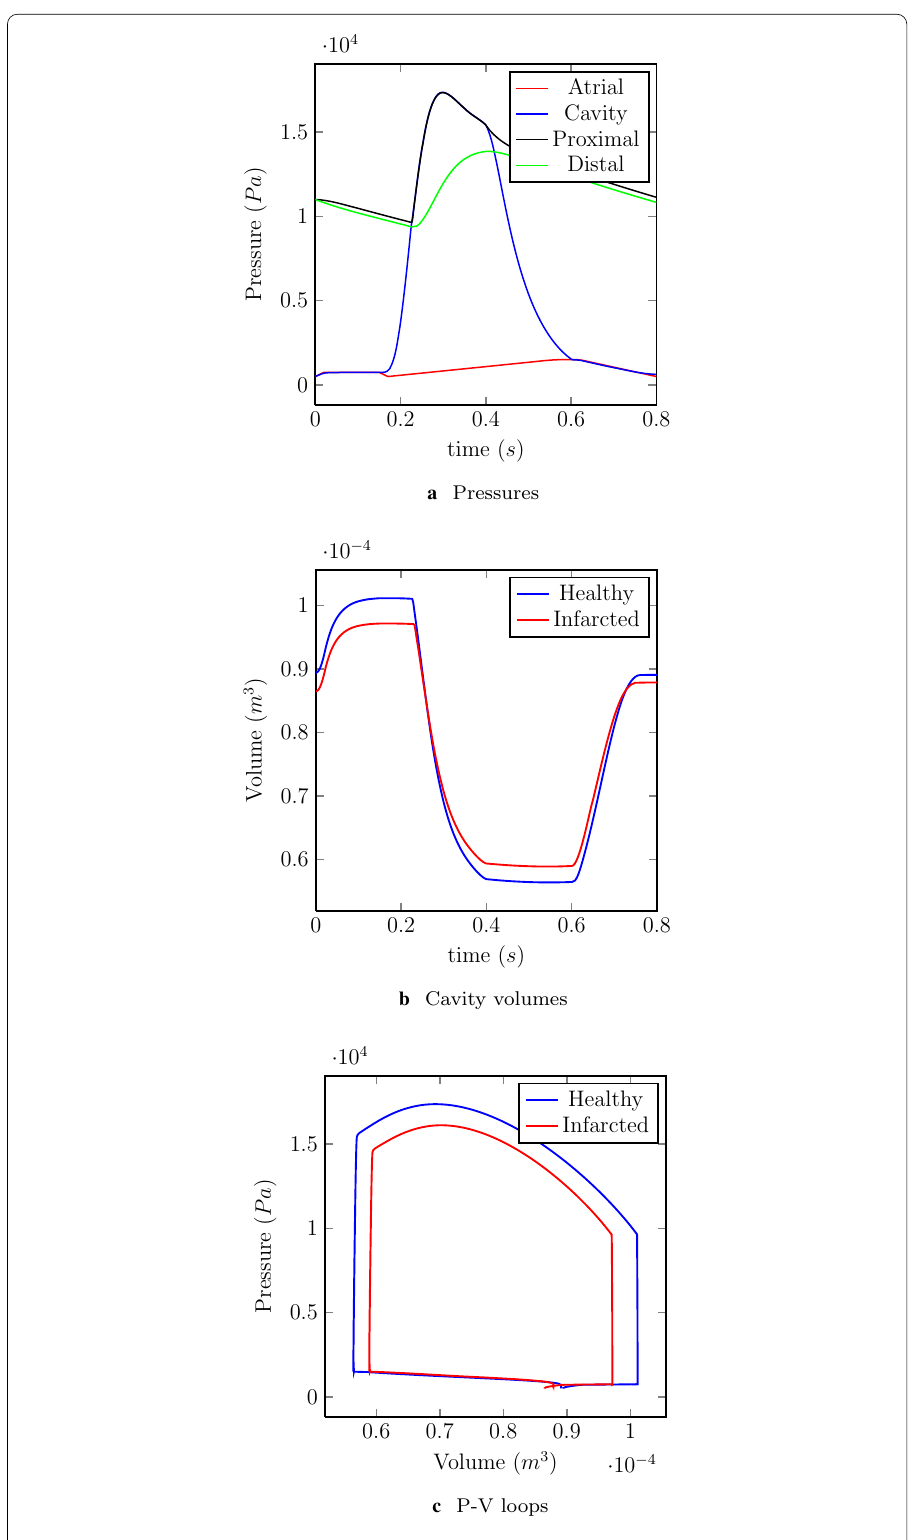
Fig. 7 Some indicators obtained from direct simulations for a healthy and infarcted